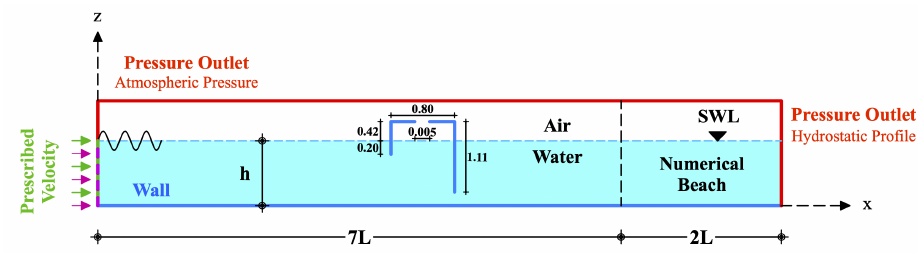
Figure 7. Computational domain used for validation of the proposed methodology.